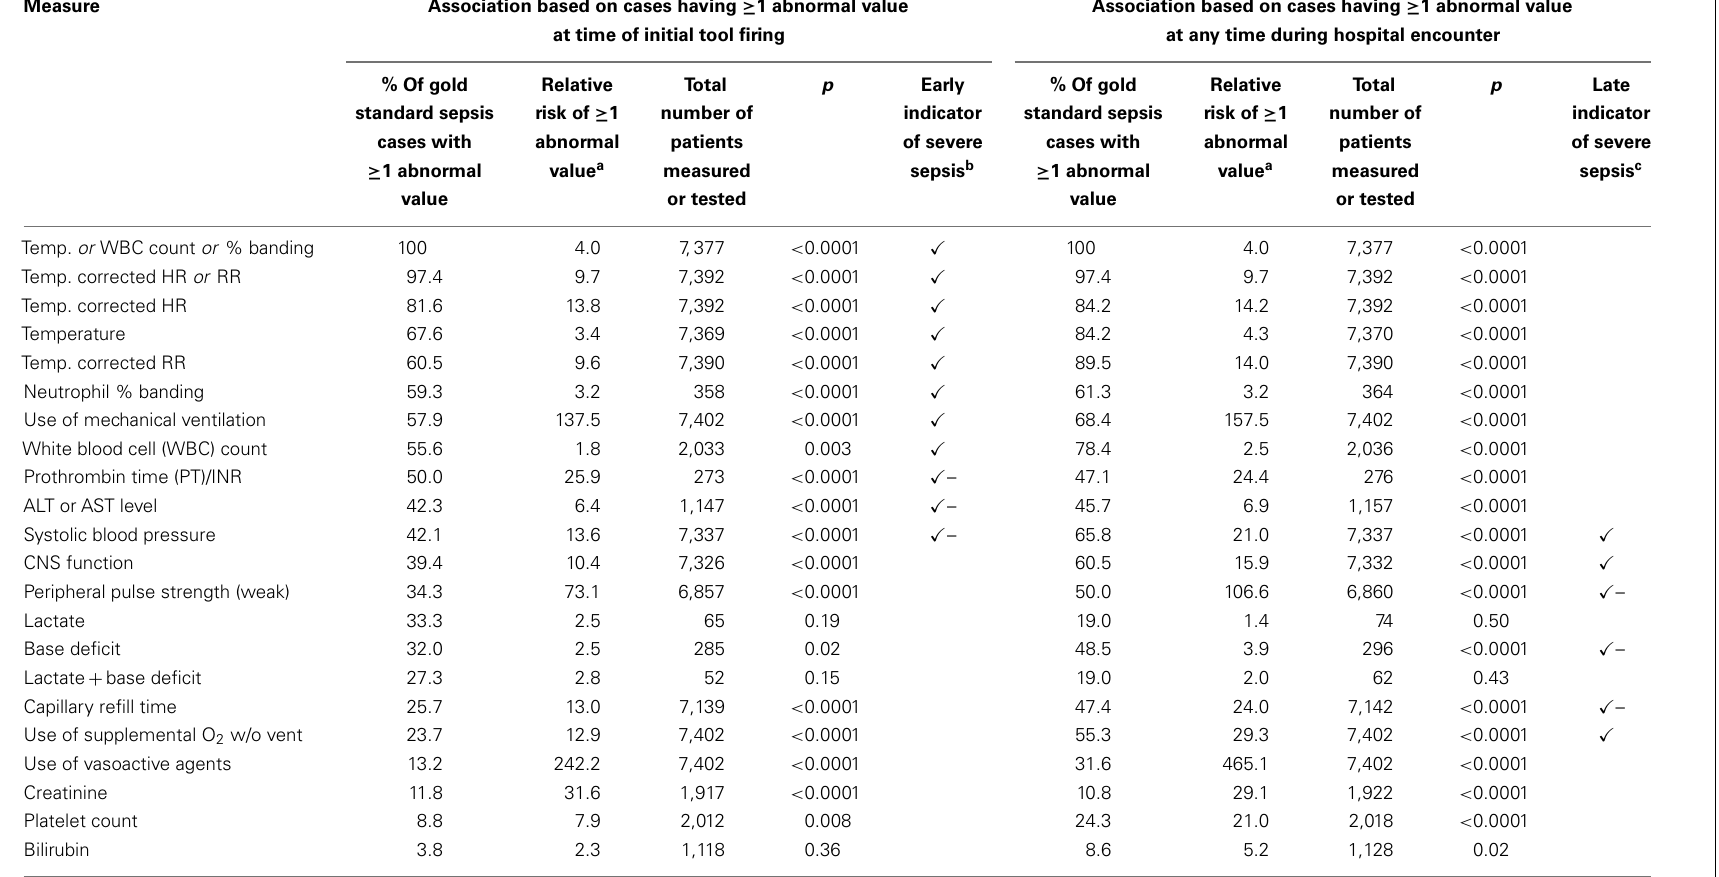
Table 4 |Association of severe sepsis with abnormal SIRS and OD metrics